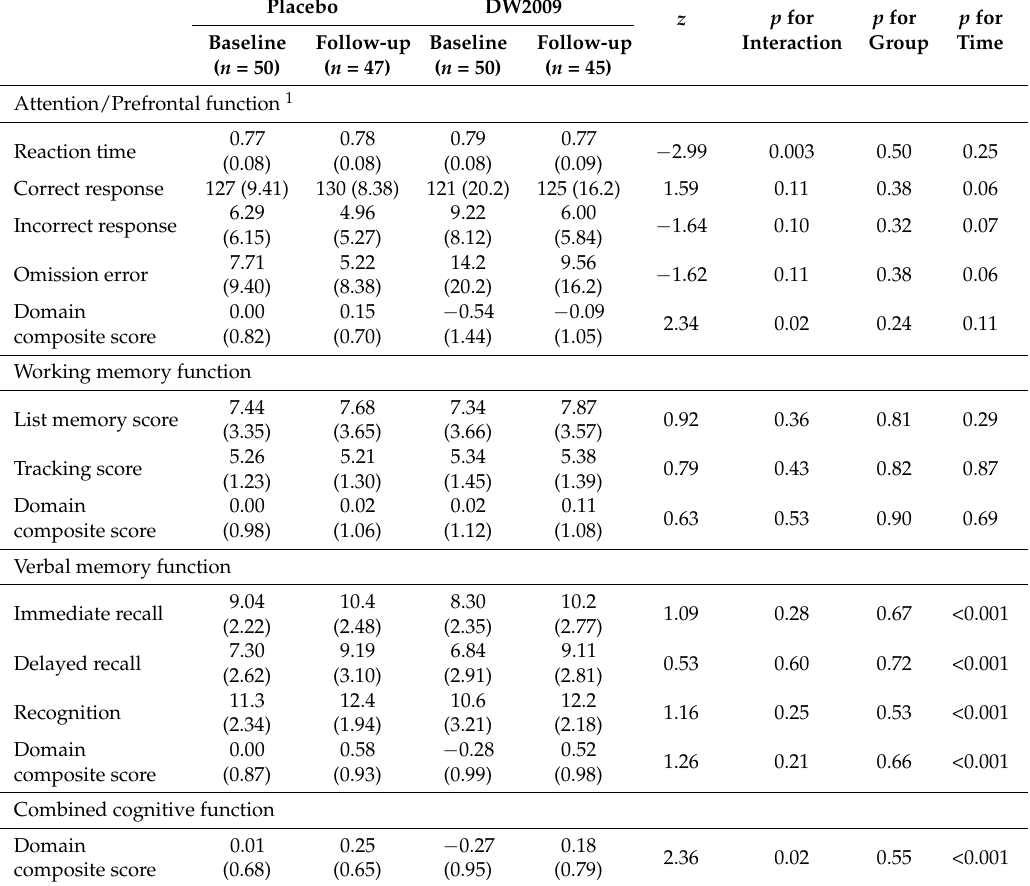
Table 2. Composite scores of attention, working memory, and verbal memory function measured using the computerized neurocognitive function tests between the groups at baseline and after 12 weeks of treatment. Placebo DW2009